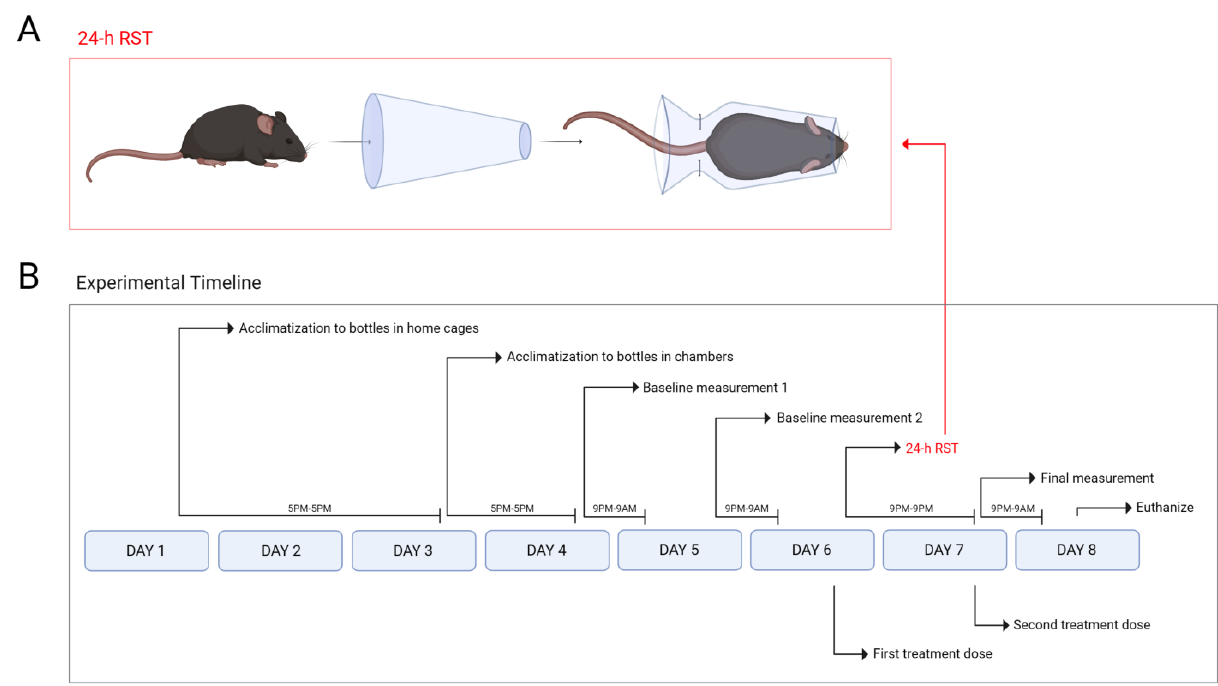
Figure 1. Experimental methods and timeline. ( A ) 24 h RST using a DecapiCone restraint apparatus. Mice were placed in the cone such that their noses poked out the opening. Metal staples were used to tightly secure mice within the cone. Mice could not move around; however, they were easily able to breathe. ( B ) Experimental timeline for the SPT including the 24 h RST. From 17:00 on day 1 to 17:00 on day 3, all mice were acclimatized to the water and sucrose solution-containing bottles in their home cages for 48 h. From 17:00 on day 3 to 17:00 on day 4, mice habituated to the SPT